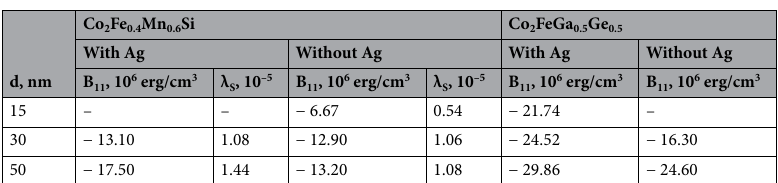
Co 2 Fe 0.4 Mn 0.6 d, nm